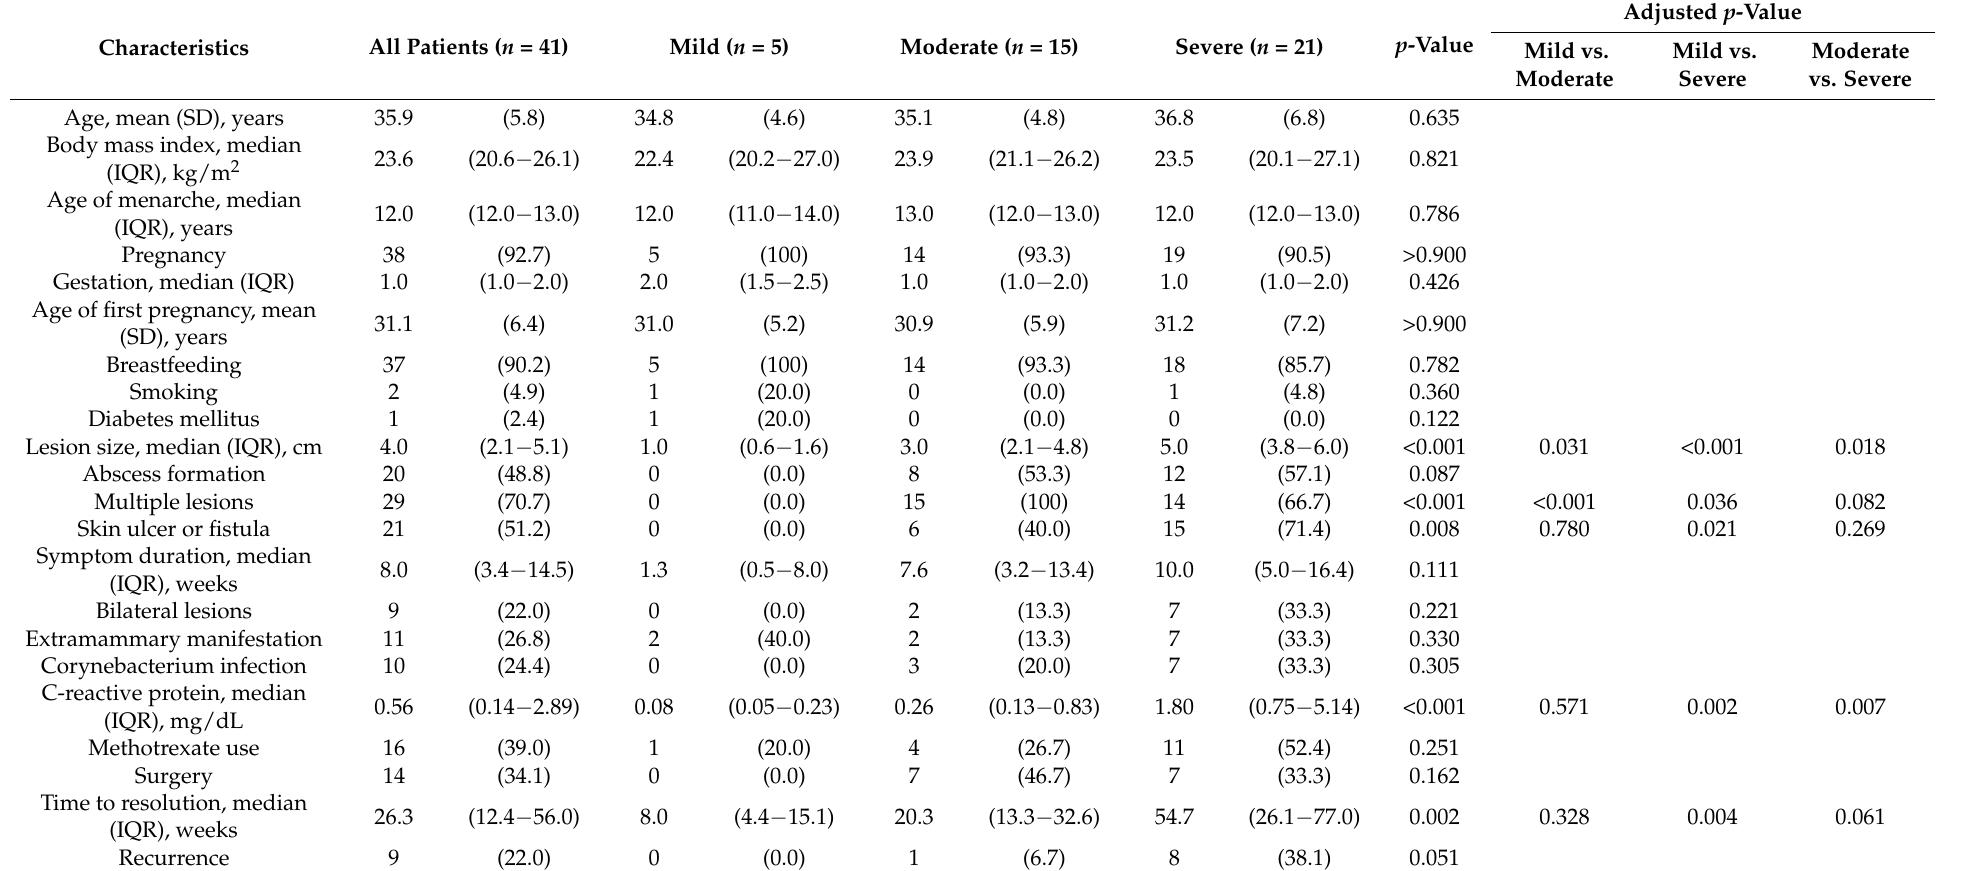
Table 1. Clinical features, serum C-reactive protein level, treatment modalities, and outcomes of patients with idiopathic granulomatous mastitis according to disease severity.